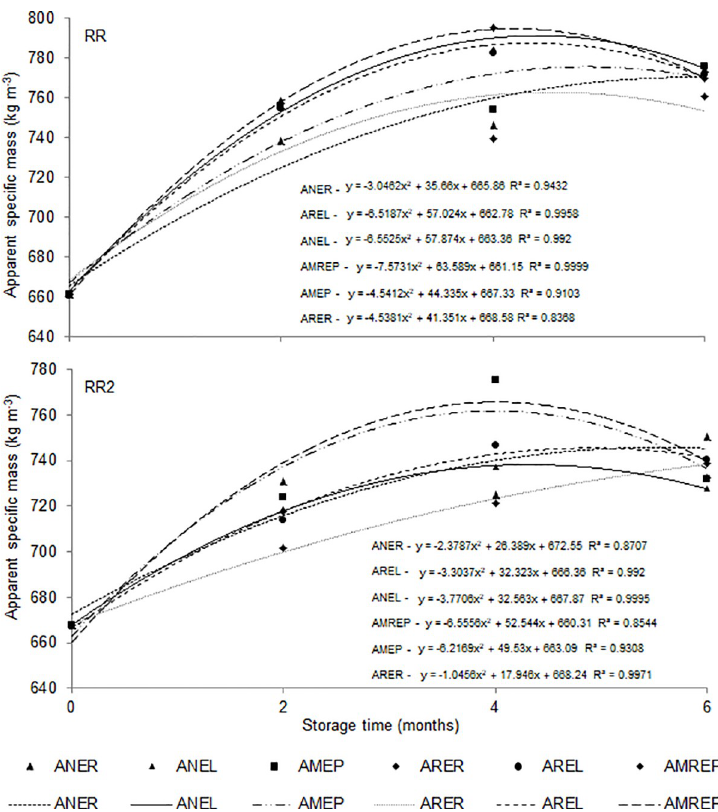
Fig 4. Apparent specific mass (kg/m 3 ) of soybean seeds of cultivar RR and RR2 as a function of different conditions and storage time. Ambient air + raffia packaging—ANER, Ambient air + packaging laminate packaging— ANEL, modified atmosphere (-14 PSI) + polyethylene packaging—AMEP, refrigerated atmosphere (1 to 3˚C) + raffia packaging—ARER, refrigerated atmosphere (1 to 3˚C) + laminate packaging—AREL, modified atmosphere (-14 PSI) + polyethylene packaging + refrigerated (1 to